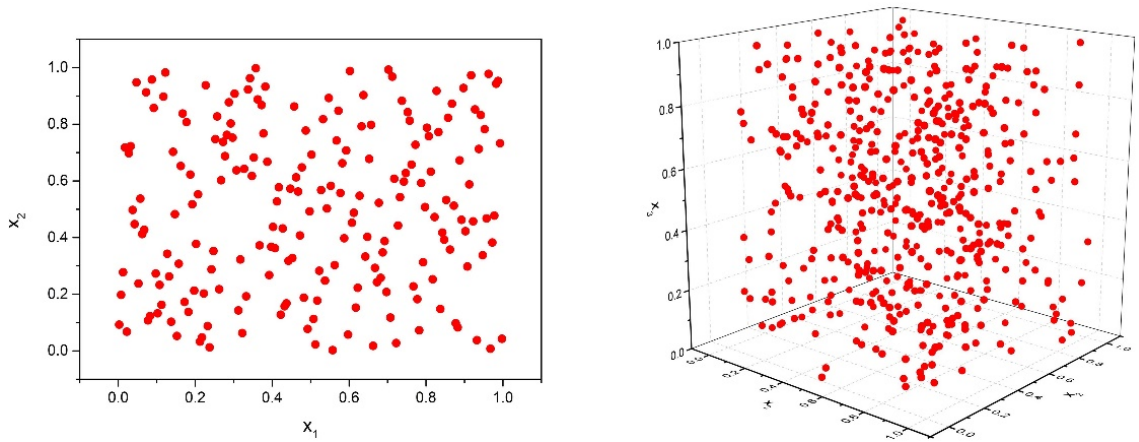
Figure 2. Experimental design of the LHS method in 2D ( left ) and 3D ( right ).